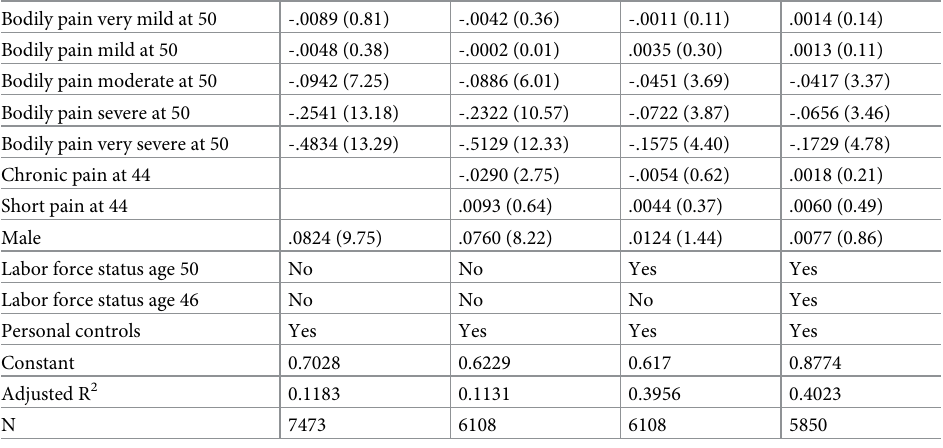
Table 11. Paid Work in NCDS9 at